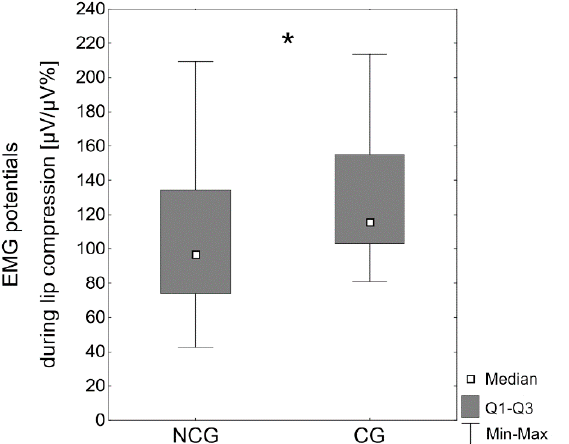
Figure 3. EMG potentials of the upper lip [µV/µV%] during lip compression in the noncleft group (NCG) and the cleft group (CG); * p < 0.05.